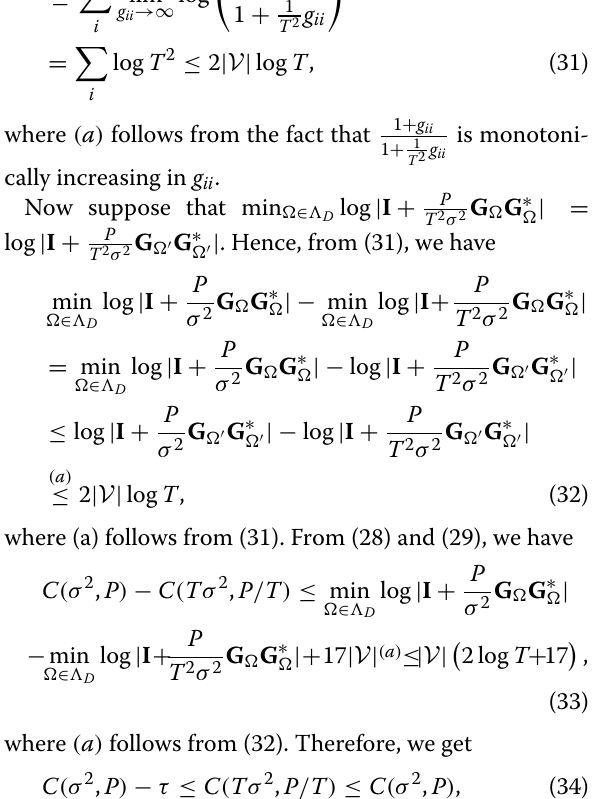
Figure 8 is the single-layer ( 3, 2 ) folded-chain network corresponding to the downlink cellular system of Fig. 7.